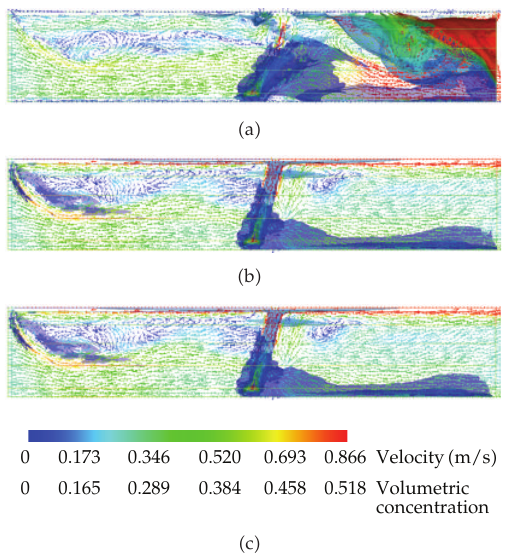
Figure 8: Combined velocity vector and isosurface plots for Model 3 at t (cid:8) 55s. From top to bottom: boundary conditions as per Section 3 (cid:2) base settings (cid:3) , slip in the x -direction, slip in the x -direction and C (cid:8) 0 at the tunnel outlet. The colour bar applies to all three